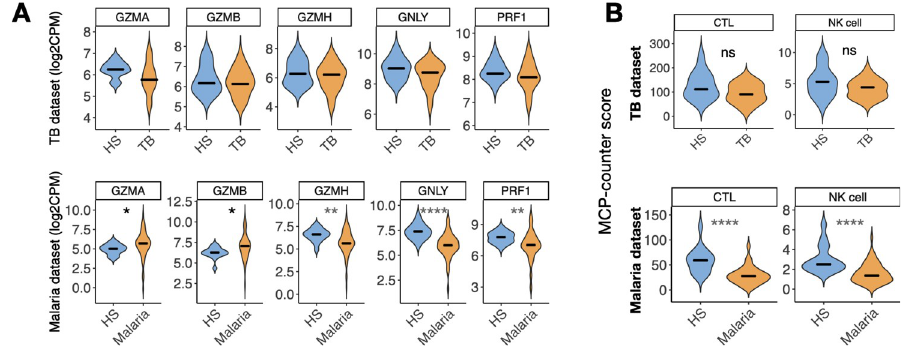
Fig 6. The CTL/NK cells signature observed in the peripheral blood of CL is unique when compared to the blood of patients with active TB and malaria. (A) Expression of genes encoding associated with cytolysis ( GZMA , GZMB , GZMH , GNLY , and PRF1 ) in the peripheral blood of patients with active TB (top) and malaria (bottom) and study controls (healthy subjects, HS). Wilcoxon rank-sum test was used for statistical analysis, � P < 0.05, �� P < 0.01, ���� P < 0.0001. CPM, counts per million log2 scale. (B) Median of MCP-counter scores between patients with active TB or malaria (yellow) and study controls (blue). Wilcoxon rank-sum test was used for statistical analysis, �� P < 0.01, ���� P <